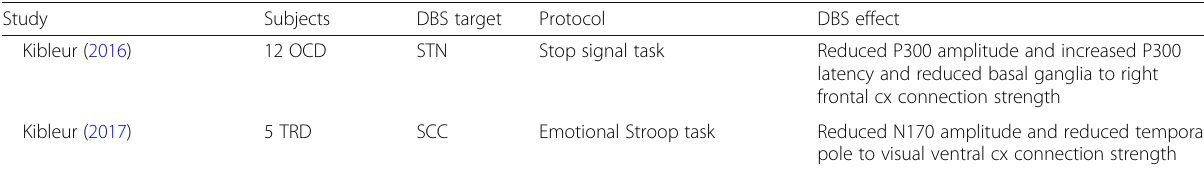
Table 1 Summary of EEG DBS studies and their principal results. Subjects number were given only for those who had direct stimulation or ON/OFF DBS protocol